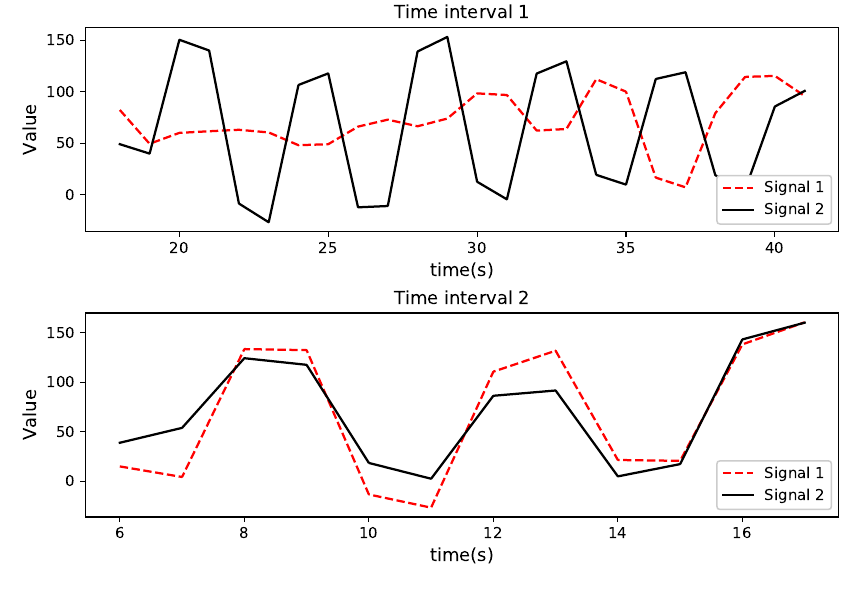
Figure 1. Example of the maximum marginal